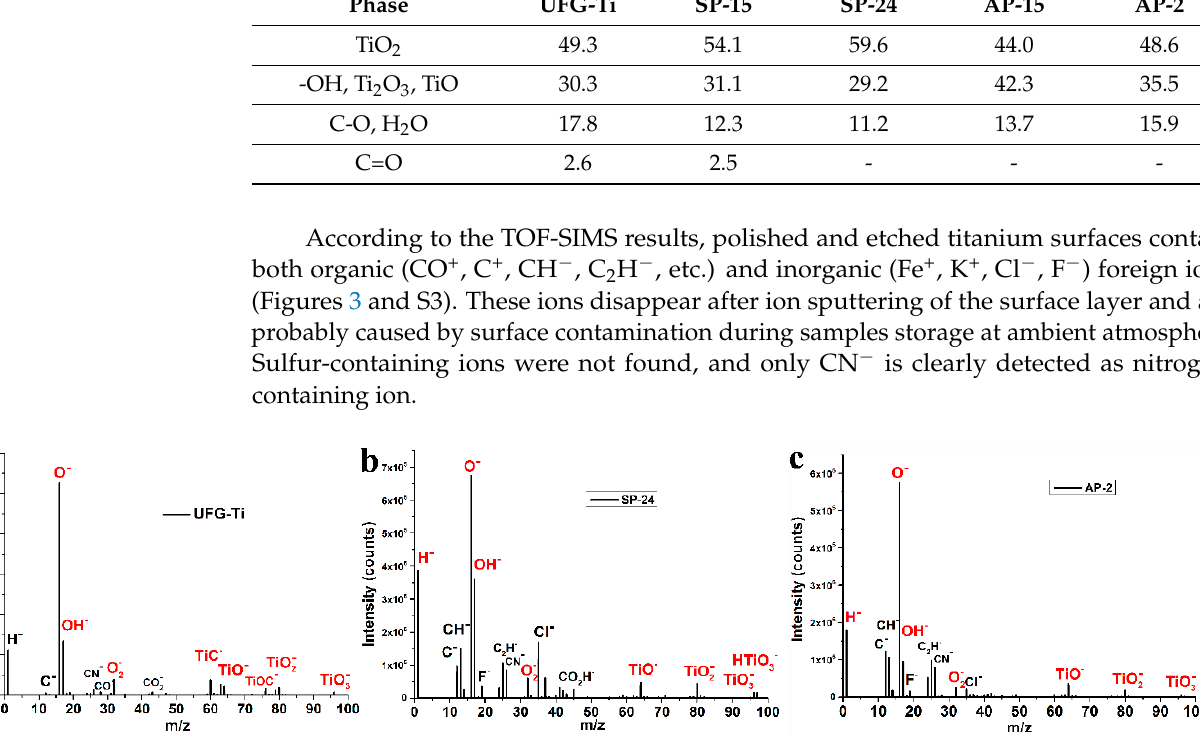
Table 3. Percentage of O forms based on O1s spectra deconvolution.